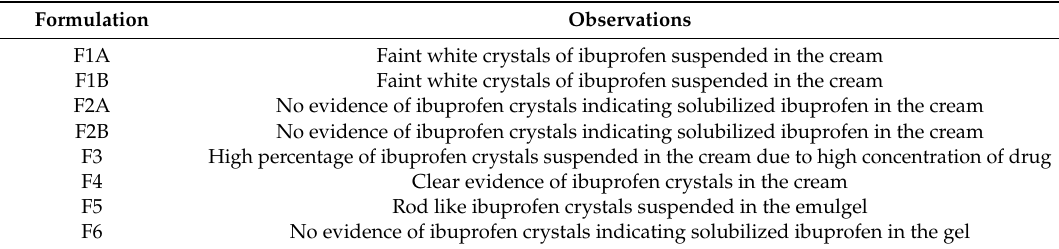
Figure 2. Polarized light microphotographs of formulations. Images were captured using Amscope polarized light microscope at 180 × magnification. F1A, ibuprofen suspended cream (3% w / w ) with Tefose 63, F1B, ibuprofen suspended cream (3% w / w ) without Tefose 63, F2A, ibuprofen solubilized cream (3% w / w ) with HPMC, F2A, ibuprofen solubilized cream (3% w / w ) without HPMC, F3, ibuprofen suspended cream (5% w / w ), F4 ibuprofen suspended cream (5% w / w ), F5, ibuprofen emulgel (3% w / w ), F6, ibuprofen clear non aqueous gel (3% w / w ). Table 6. Observations from polarized light